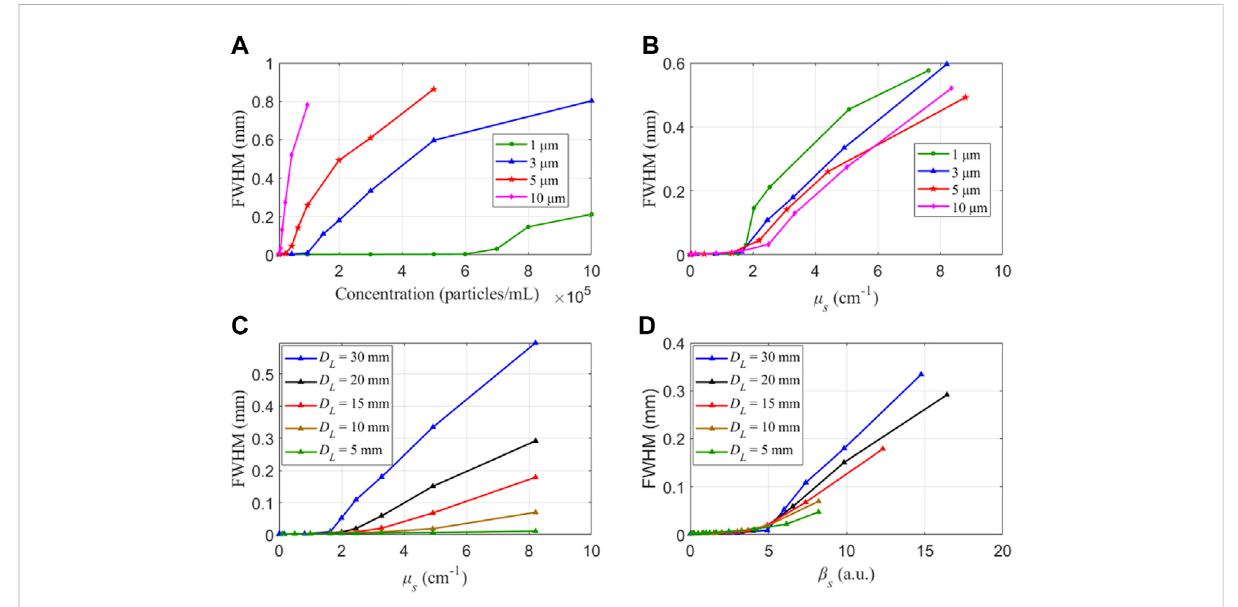
FIGURE 5 In fl uences of different factors on the FWHM. (A) Different concentrations and sizes; (B) different μ s and sizes; (C) different μ s and D L ; (D) Different β s and D L